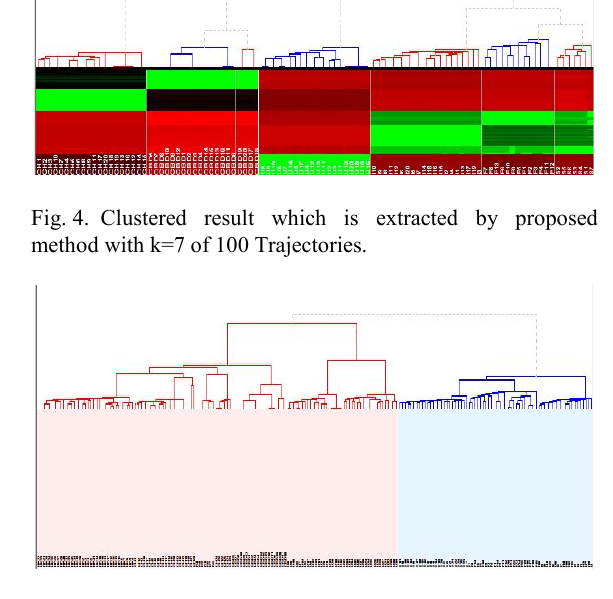
Fig. 5. Clustered result which is extracted by proposed method with k=2 of 100